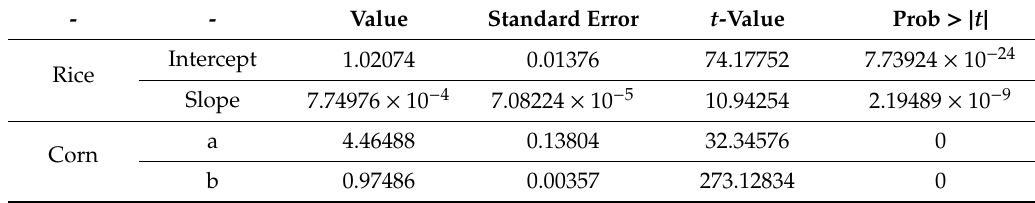
Table 8. Test results of the regression model coe ffi cient significance for an 80% fragmentation degree.